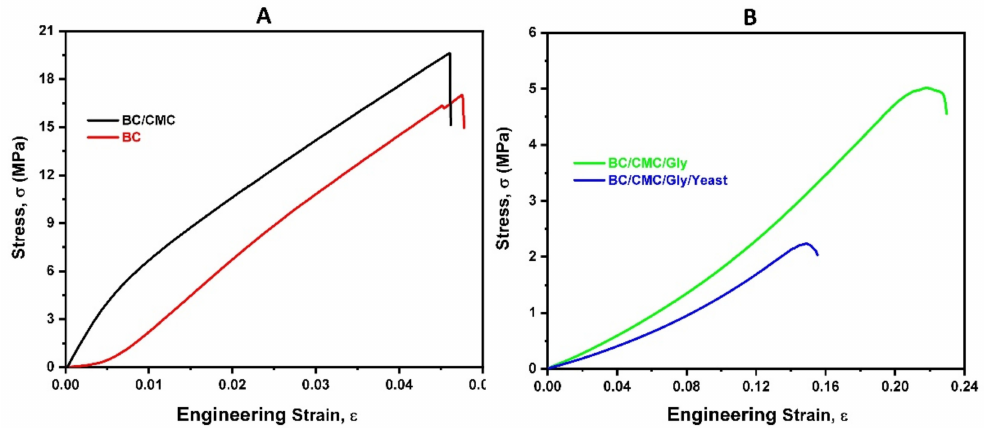
Figure 1. Stress–strain curves of ( A ) pristine BC and BC/CMC composite film and ( B ) BC/CMC/Gly and BC/CMC/Gly/yeast composite